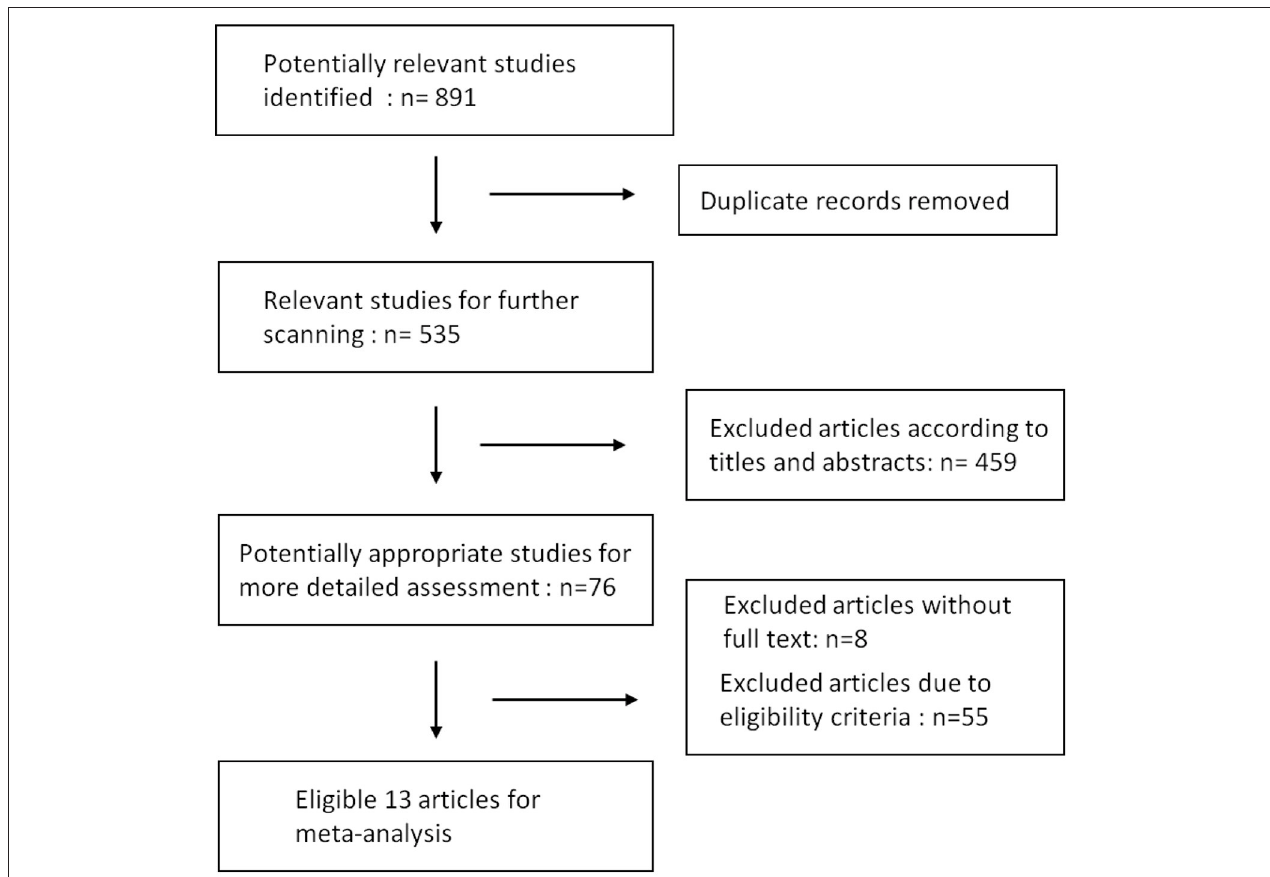
FIGURE 1 | Flowchart of literature search and study selection.